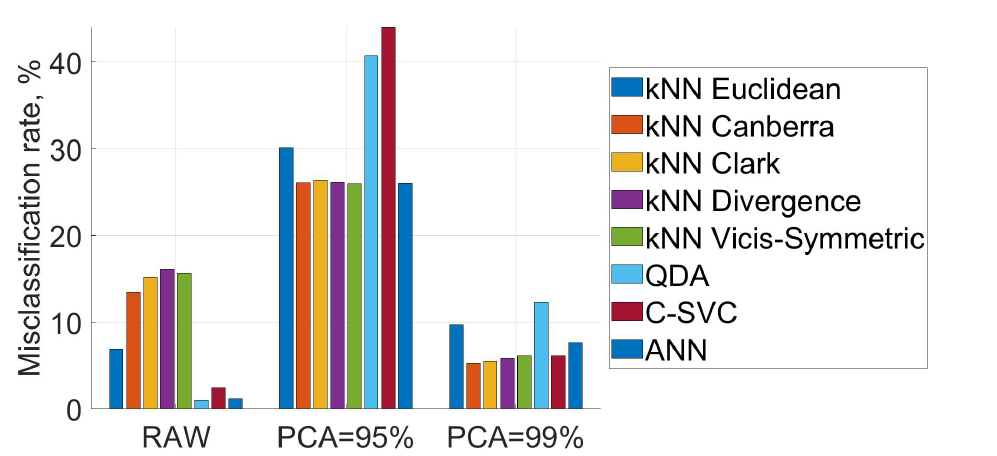
Figure 3. Misclassification rates of eight different classifiers. RAW indicates that raw IMS data was used and PCA indicates that PCA-transformed data explaining x % of the total variance in raw IMS data was used for classification. The presented misclassification rates are average rates over the five